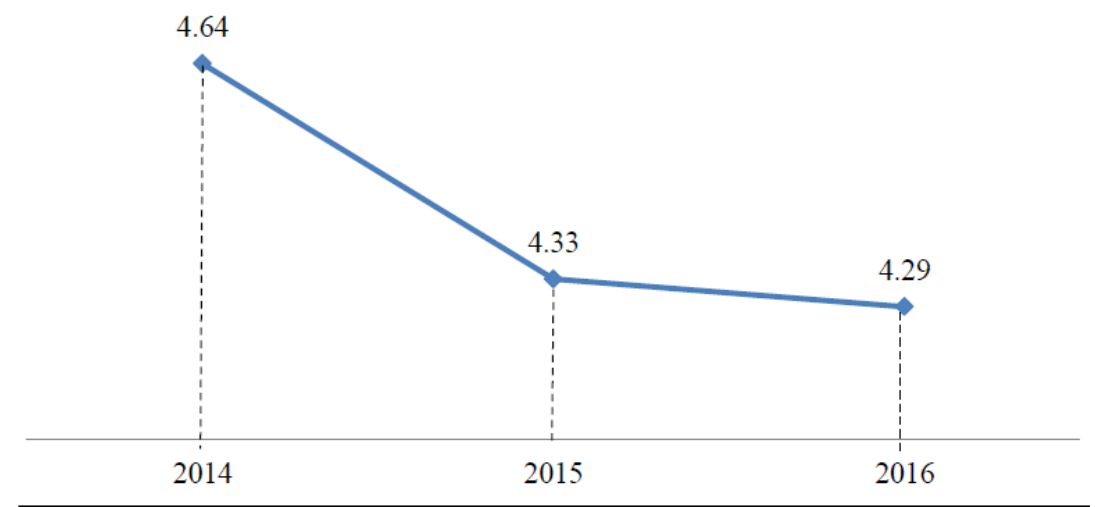
Figure 3: Indonesia Manufacturing Sector Growth Period 2014-2016 (in percent) Source:Bank